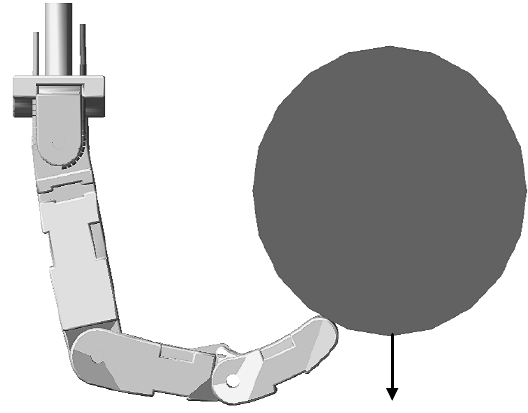
Figure 16. The direction of the row is the direction of the change.